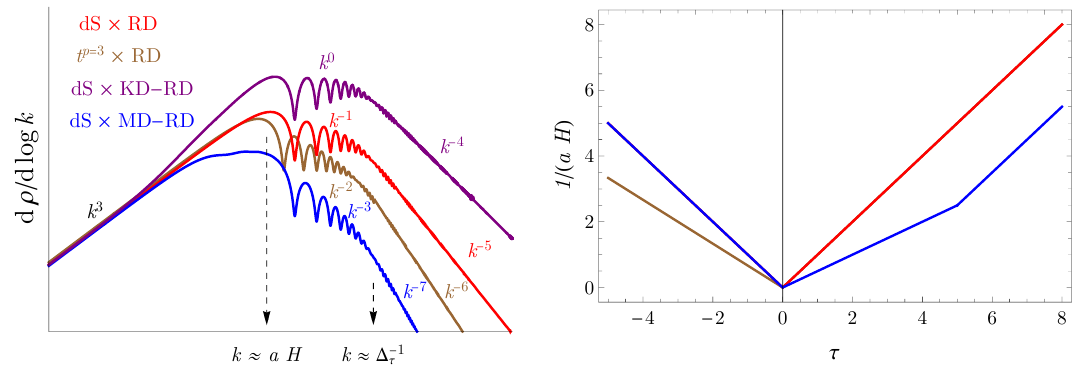
Figure 4 . On the left panel, we compare spectral shapes of the GW signal in a few non-minimal scenarios of the early universe, including an intermediate period of matter domination (blue) or a kination domination (purple) after the end of inflation, and a t p -inflation scenario with p = 3 (brown). On the right panel, we plot the co-moving horizon as a function of conformal time for these scenarios. We fix the scale factor a and the conformal time τ ? when phase transition take place. The same rules apply for the comoving horizon plots in the rest of the